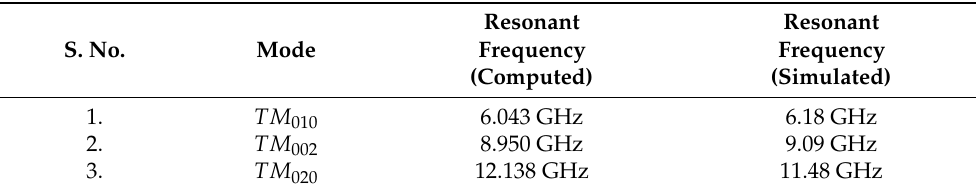
Table 4. Computed and simulated resonant frequencies of various TM mnp modes for the rectangu- lar MPA.